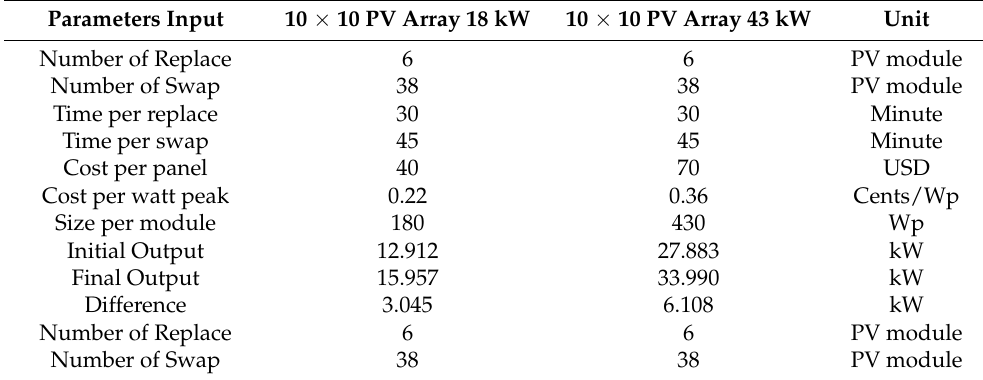
Table 9. The PV array 10 × 10 parameter inputs.